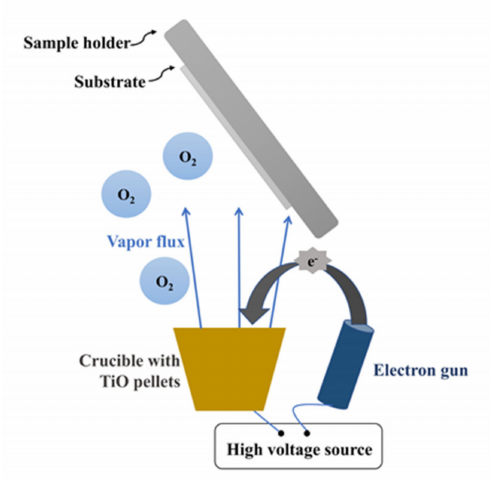
Figure 7. Electron-beam physical vapor deposition with OAD configuration for obtaining TiO 2 NCs. A target anode (contained in a crucible) is bombarded with an electron beam emitted by a charged tungsten filament (electron gun) under high vacuum. The electron beam causes the evaporation of the target material: the ejected atoms react with oxygen atoms from O 2 gas molecules and precipitate into solid form, coating the substrate with TiO 2